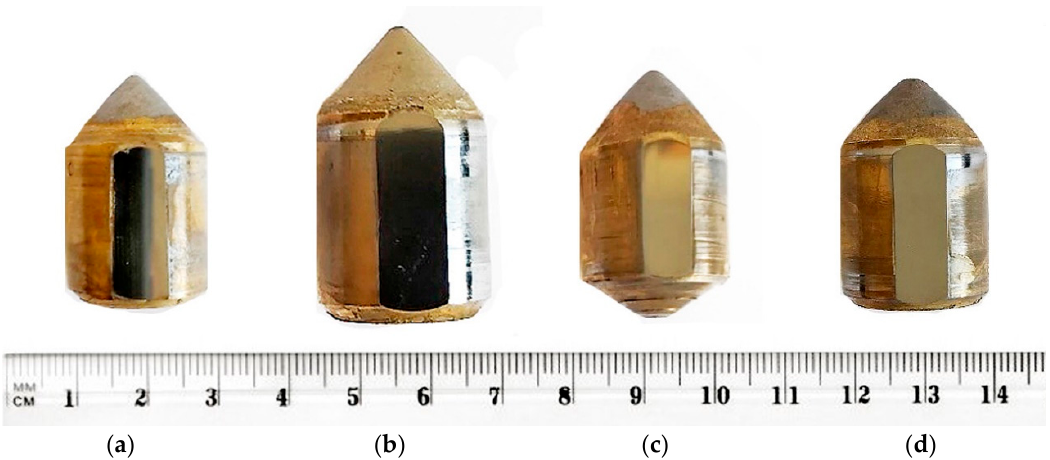
Figure 3. Comparison of sintered carbide tips assigned for the tests: ( a ) Road 1, ( b ) Road 2, ( c ) Longwall 1, ( d ) Longwall 2.